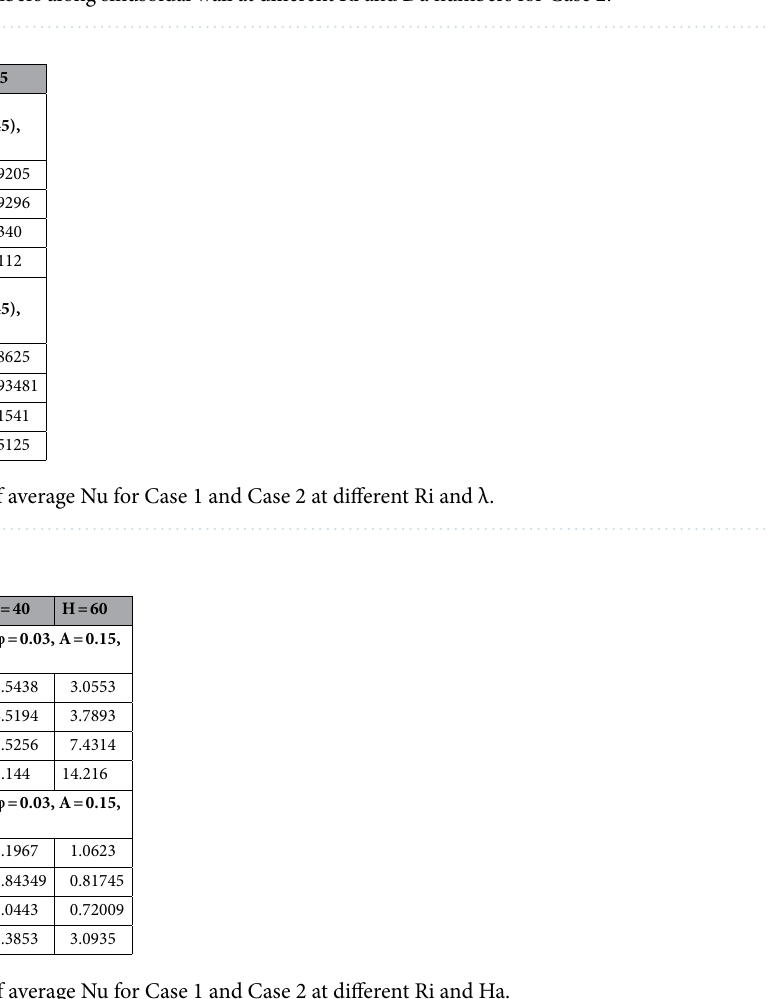
Table 14. Comparison of average Nu for Case 1 and Case 2 at different Ri and